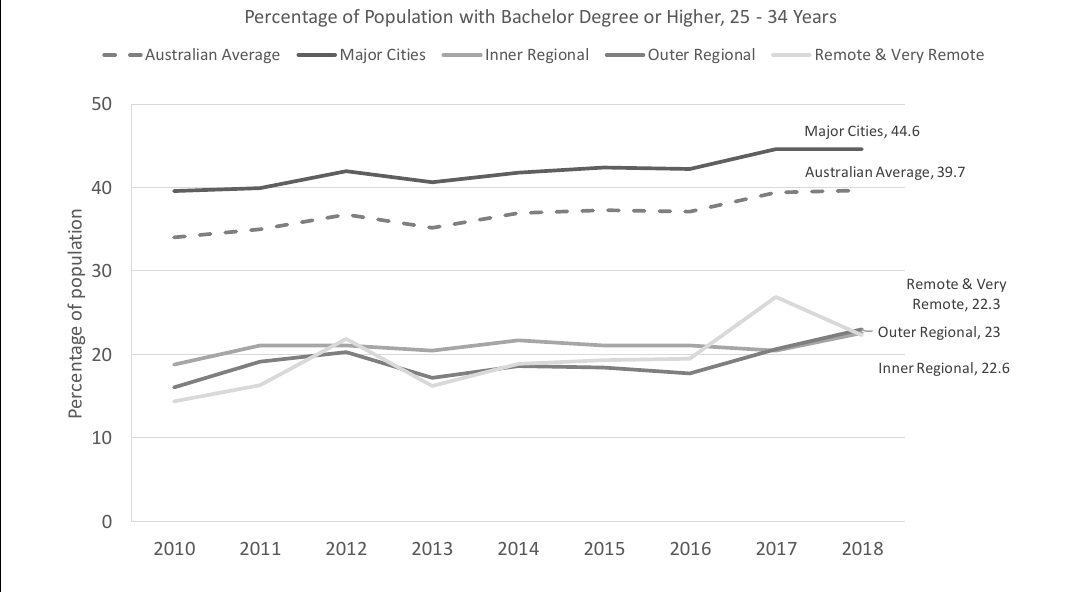
Figure 1. Percentage of population with bachelor’s degree or higher, age 25 – 34 years (ABS,